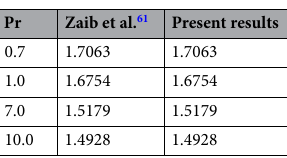
0 and all other parameters are =